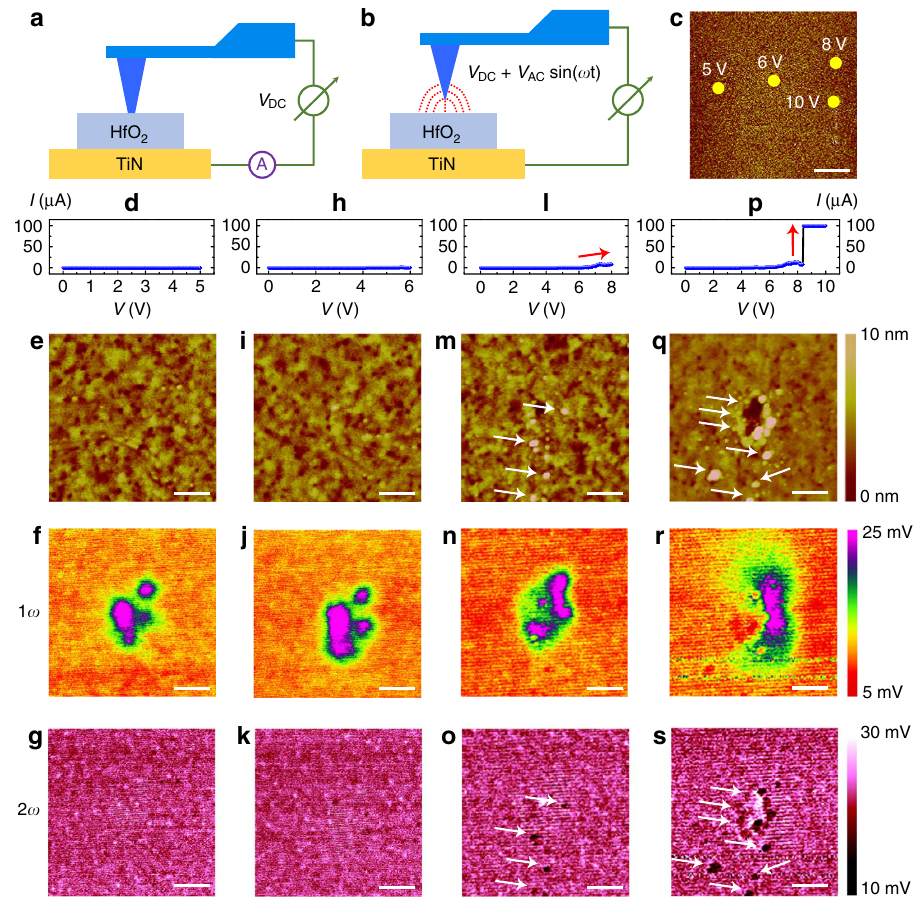
Figure 1 | Imaging of dynamic ion accumulation during resistance switching process. ( a ) Schematic of the conductive atomic force microscopy (C-AFM) measurements on HfO 2 /TiN samples. ( b ) Schematic of the electrostatic force microscopy (EFM) measurements on HfO 2 /TiN samples. ( c ) Topographic image showing the locations where voltage sweepings with different amplitudes were performed. Scale bar, 4 m m. ( d – g ) Electrical ( d ), topographic ( e ), 1 o ( f ) and 2 o ( g ) measurements on the region stimulated by voltage sweeping up to 5V during preceding C-AFM measurements. Scale bar, 200nm. ( h – k ) Corresponding electrical and EFM results on the region stimulated by voltage sweeping up to 6V during preceding C-AFM measurements. Scale bar, 200nm. ( l – o ) Corresponding electrical and EFM results on the region stimulated by voltage sweeping up to 8V during preceding C-AFM measurements. Scale bar, 200nm. ( p – s ) Corresponding electrical and EFM results on the region stimulated by voltage sweeping up to 10V during preceding C-AFM measurements. Scale bar,